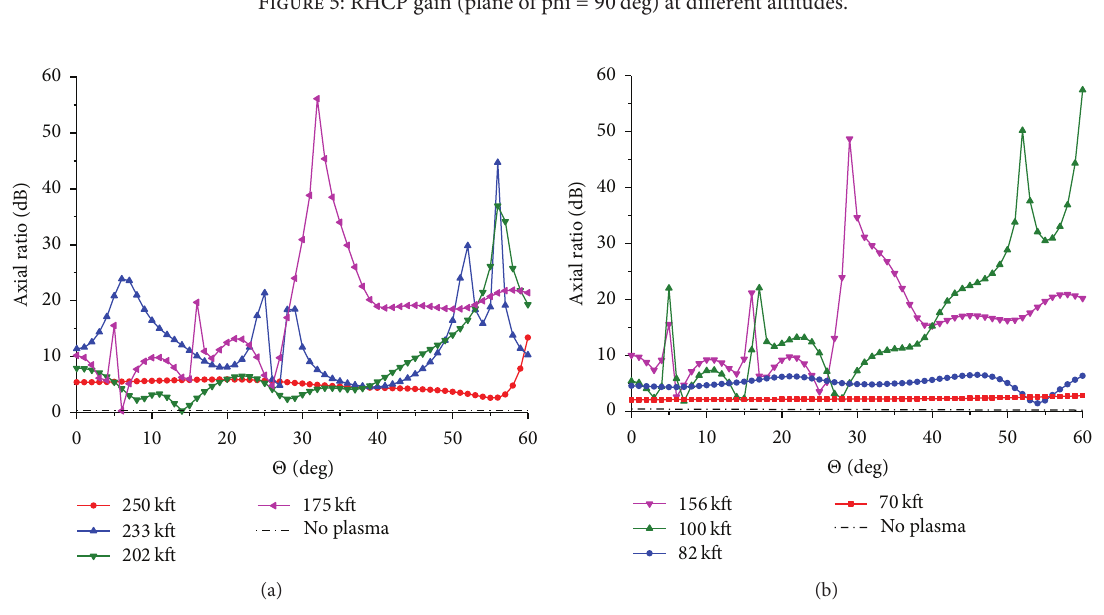
Figure 5: RHCP gain (plane of phi = 90deg) at different altitudes.